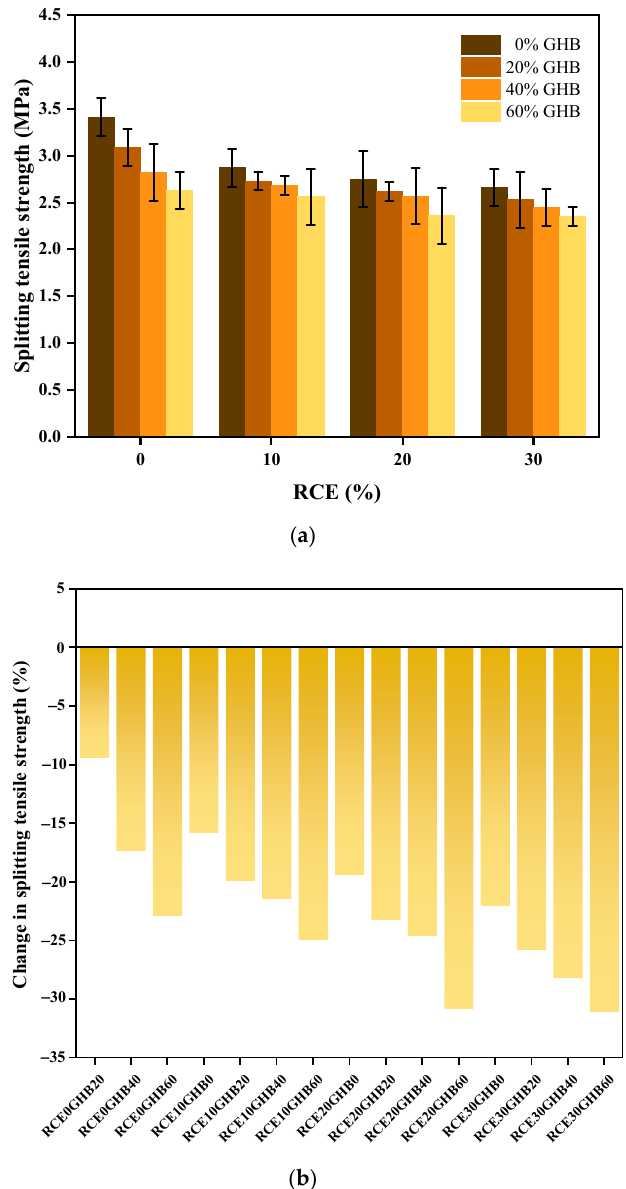
Figure 9. The experimental results and changes of splitting tensile strength subject to the coupling influence between GHB and RCE on RTIC. ( a ) The experimental results of splitting tensile strength of RTIC; ( b ) the changes of splitting tensile strength of RTIC.